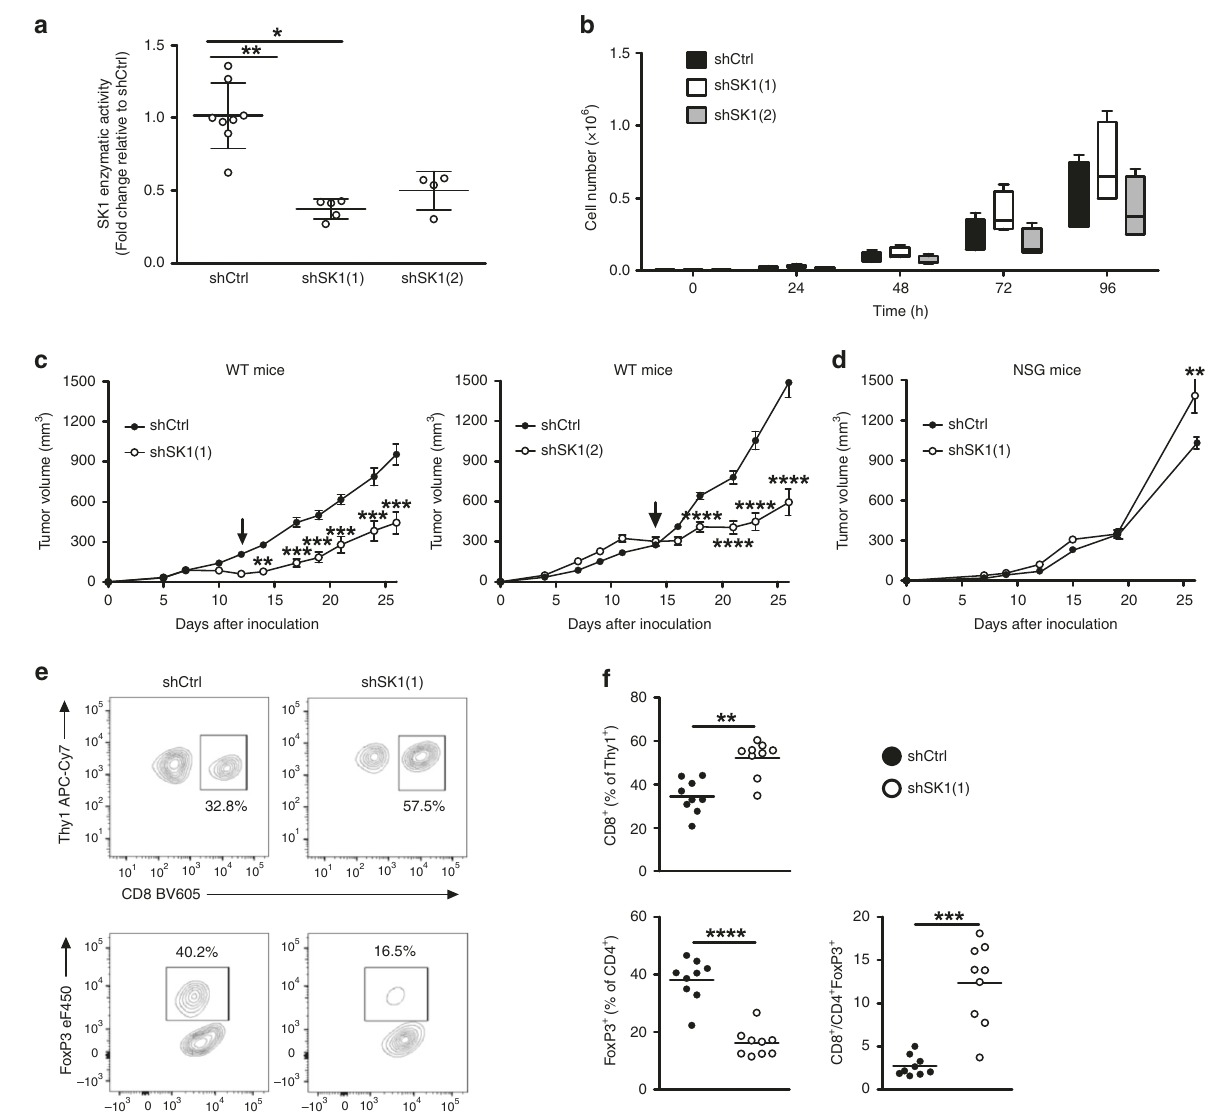
Fig. 2 SK1 downregulation increases the CD8 + /Treg ratio and reduces tumor growth. a SK1 enzymatic activity was measured in Yumm cells transfected with a control shRNA (shCtrl, black column) or two SK1-targeted shRNA (white and gray columns) (means ± SEM of 5 independent experiments). b Cell proliferation ( n = 4). Results represent means of 3 independent experiments. c shCtrl (black points), shSK1(1) or shSK1(2) (white points) Yumm cells were injected in wild-type (WT) C57BL/6 mice ( n = 12 mice/group). Arrows indicate tumor regression of shSK1 tumors. d shCtrl or shSK1(1) Yumm cells were injected in NOD scid gamma (NSG) immunode fi cient mice ( n = 5 mice/group). Tumor volume was determined at the indicated days. Tumor volumes, presented as means ± SEM, are representative of at least two independent experiments. e , f shCtrl or shSK1(1) Yumm cells were injected in C57BL/6 mice, and TIL content was analyzed by fl ow cytometry on day 11. Percentages of CD8 + (upper panel) and CD4 + Foxp3 + (Treg; lower panel) T cells and CD8 + /Treg ratio were calculated. e Representative stainings; values indicate the percentage of cells in the quadrant. f Each symbol represents an independent tumor ( n = 9 mice/group). Results are representative of at least two independent experiments. Data were compared using Kruskal – Wallis test with Dunn ’ s correction ( a , b ), two-way ANOVA test ( c , d ) or Mann – Whitney test ( e and f